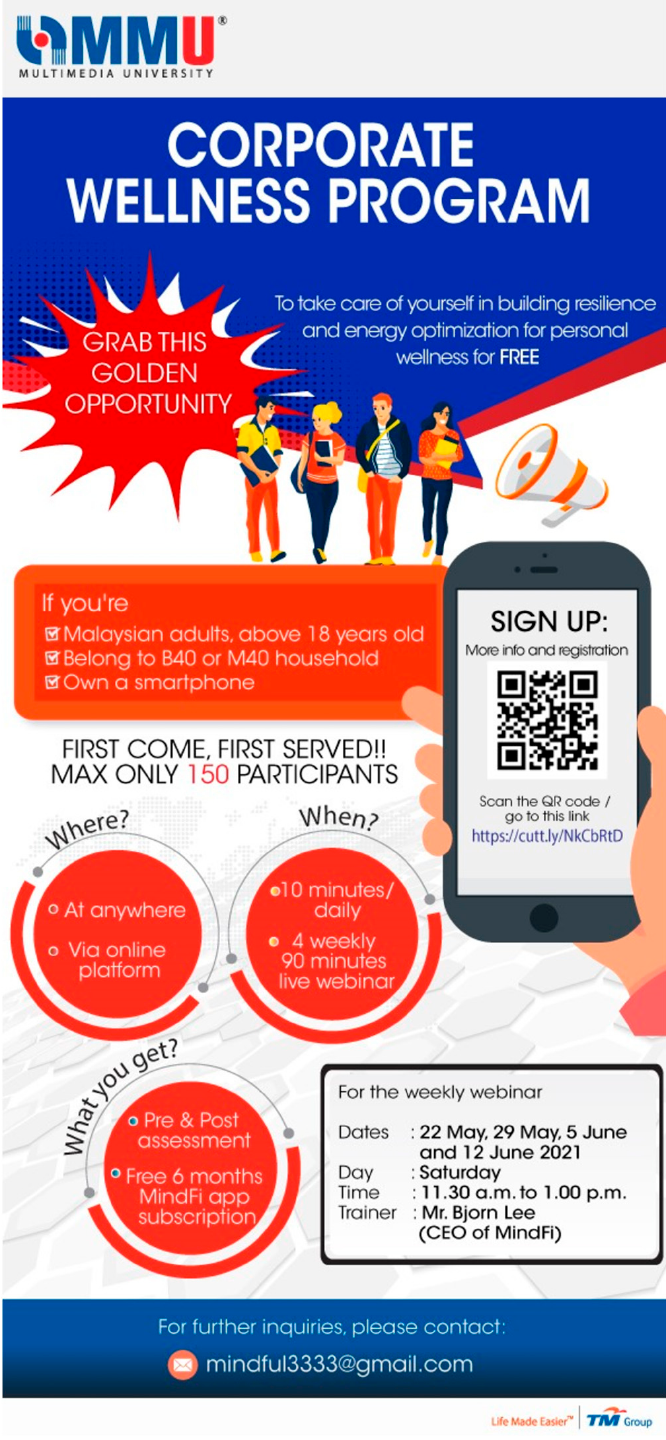
Figure A1. Recruitment Poster of Corporate Wellness Program.